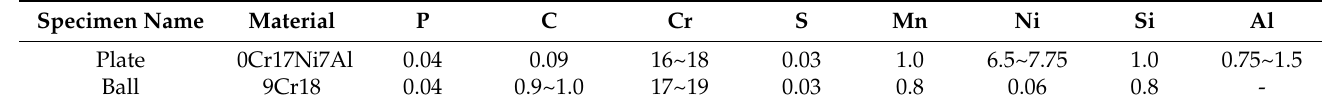
Table 7. Mass fraction and chemical composition of the two